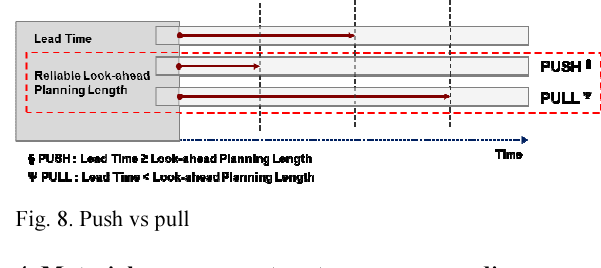
Fig. 8. Push vs pull